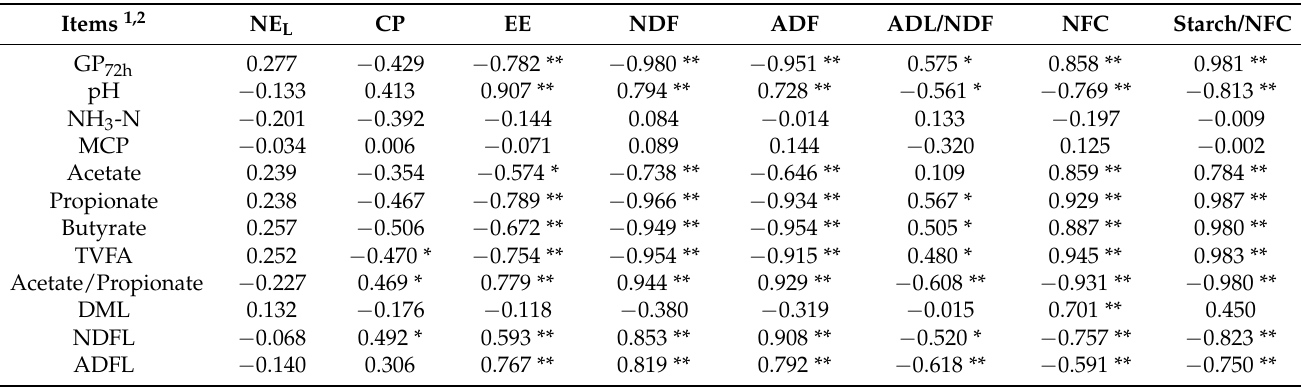
Table 5. Pearson correlation coefficients between in vitro fermentation characteristics